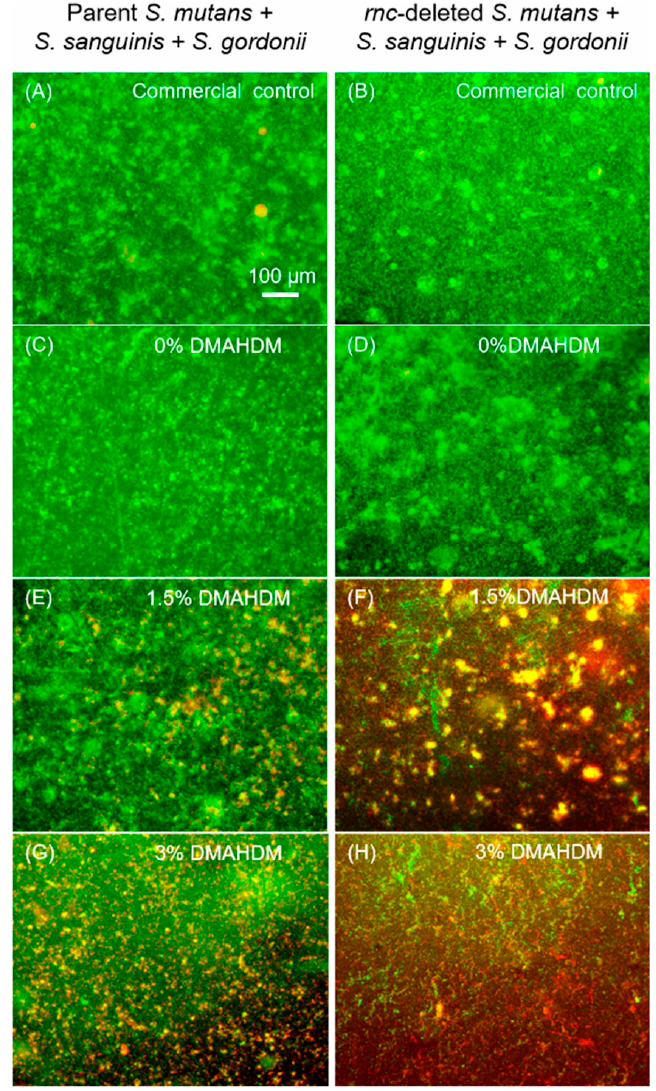
Figure 2. Representative live/dead staining images. Live/dead staining of 2-day Sm + Ss + Sg biofilms